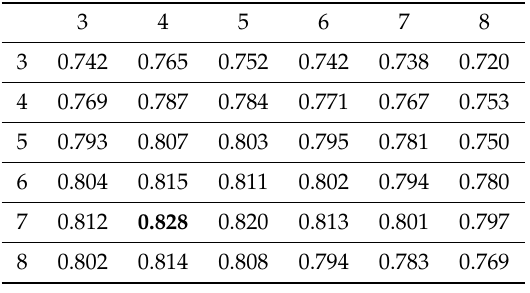
Table 2. The SRCC of the CSM in different convolutional layers on the CSIQ database. The best result is highlighted in bold.